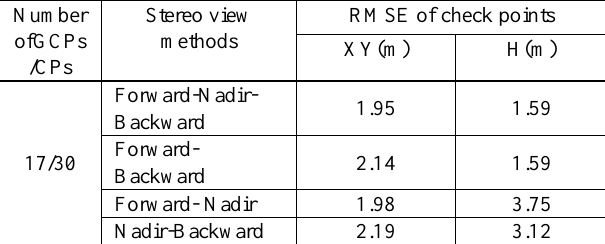
Table 2. The results of Taiyuan mainly covered with mountain